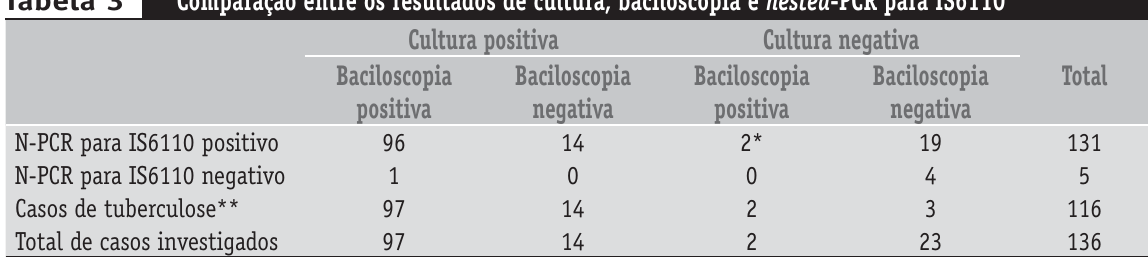
Total de casos investigados